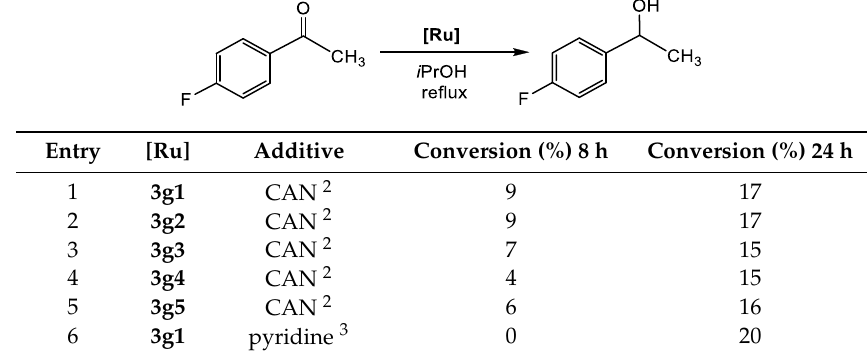
Table 2. Catalytic transfer hydrogenation of 4-fluoroacetophenone with ruthenium dendrimers 3g1 – 5 as catalyst [Ru] . 1.